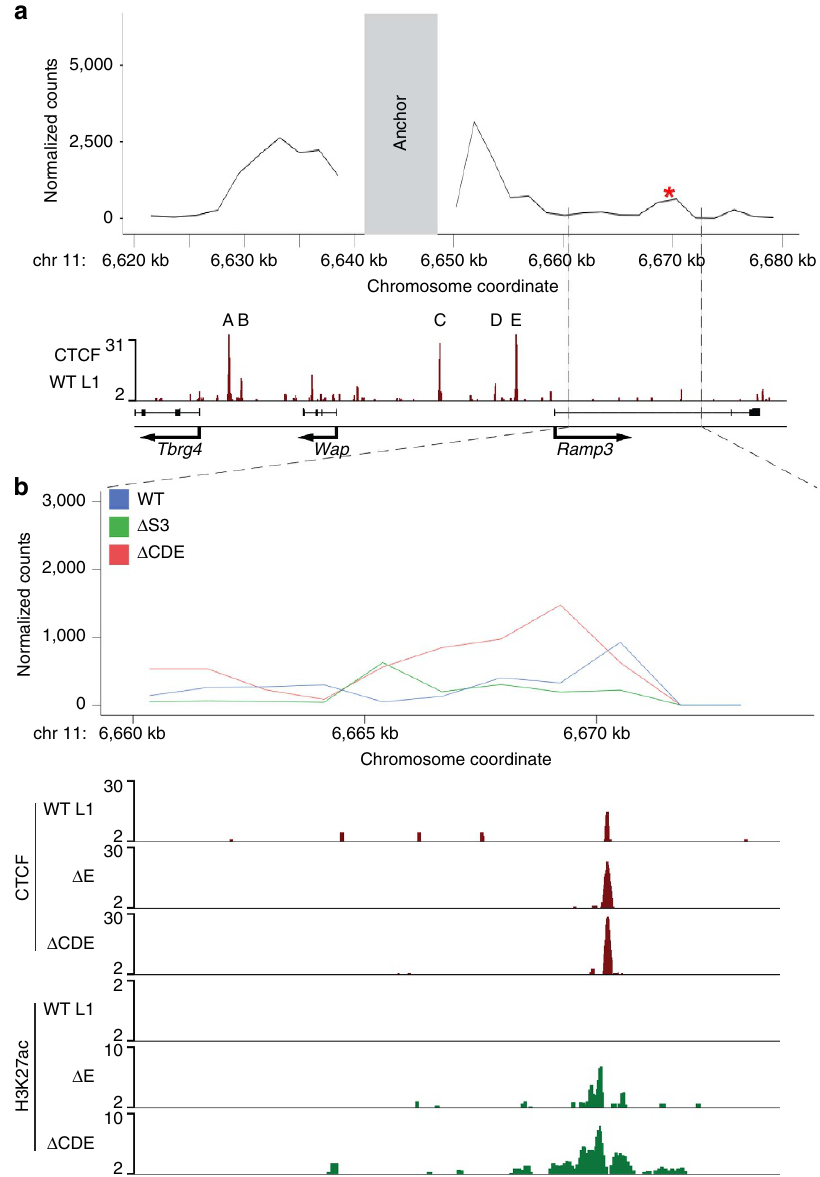
Figure 6 | Interactions between the Wap super-enhancer and the first intron of Ramp3 . ( a ) 4C data at the Tbrg4 - Wap - Ramp3 locus were obtained from wild type lactating mammary tissue. The anchor region located over the third enhancer (S3) is shaded in grey. The lower panel shows CTCF-binding sites in the Tbrg4 - Wap - Ramp3 locus. 4C interactions occurred between the first intron of Ramp3 and the anchor region (red asterisk). ( b ) 4C signal within the first intron of Ramp3 . Intronic 4C interactions in wild type (blue) were absent in D S3 mutants (green) and increased in D CDE mutants (red). The lower panel shows increased CTCF binding to the intronic site in D E and D CDE mutants along with an increase in